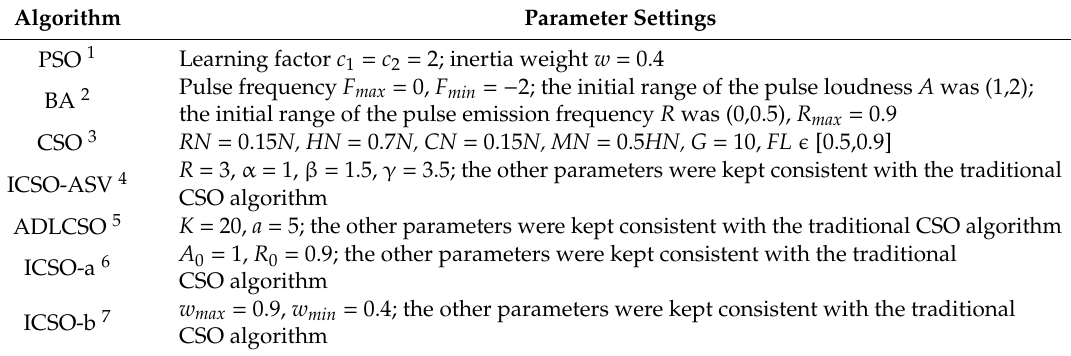
Table 2. Algorithm parameter settings.